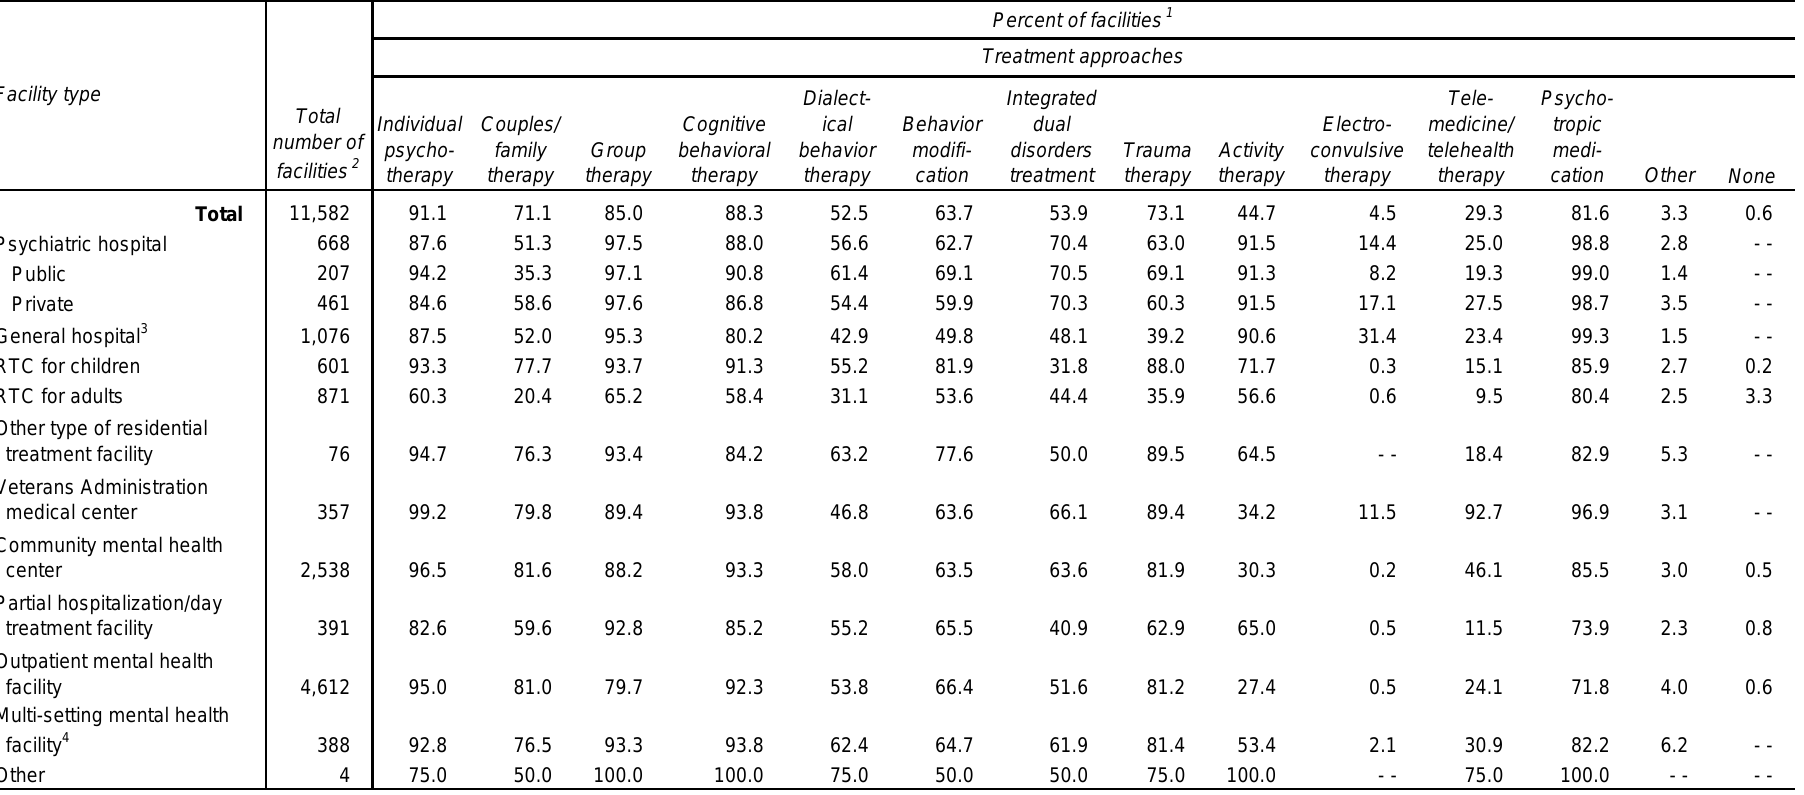
Table 2.3b. Mental health treatment facilities offering various treatment approaches, by facility type: Percent,